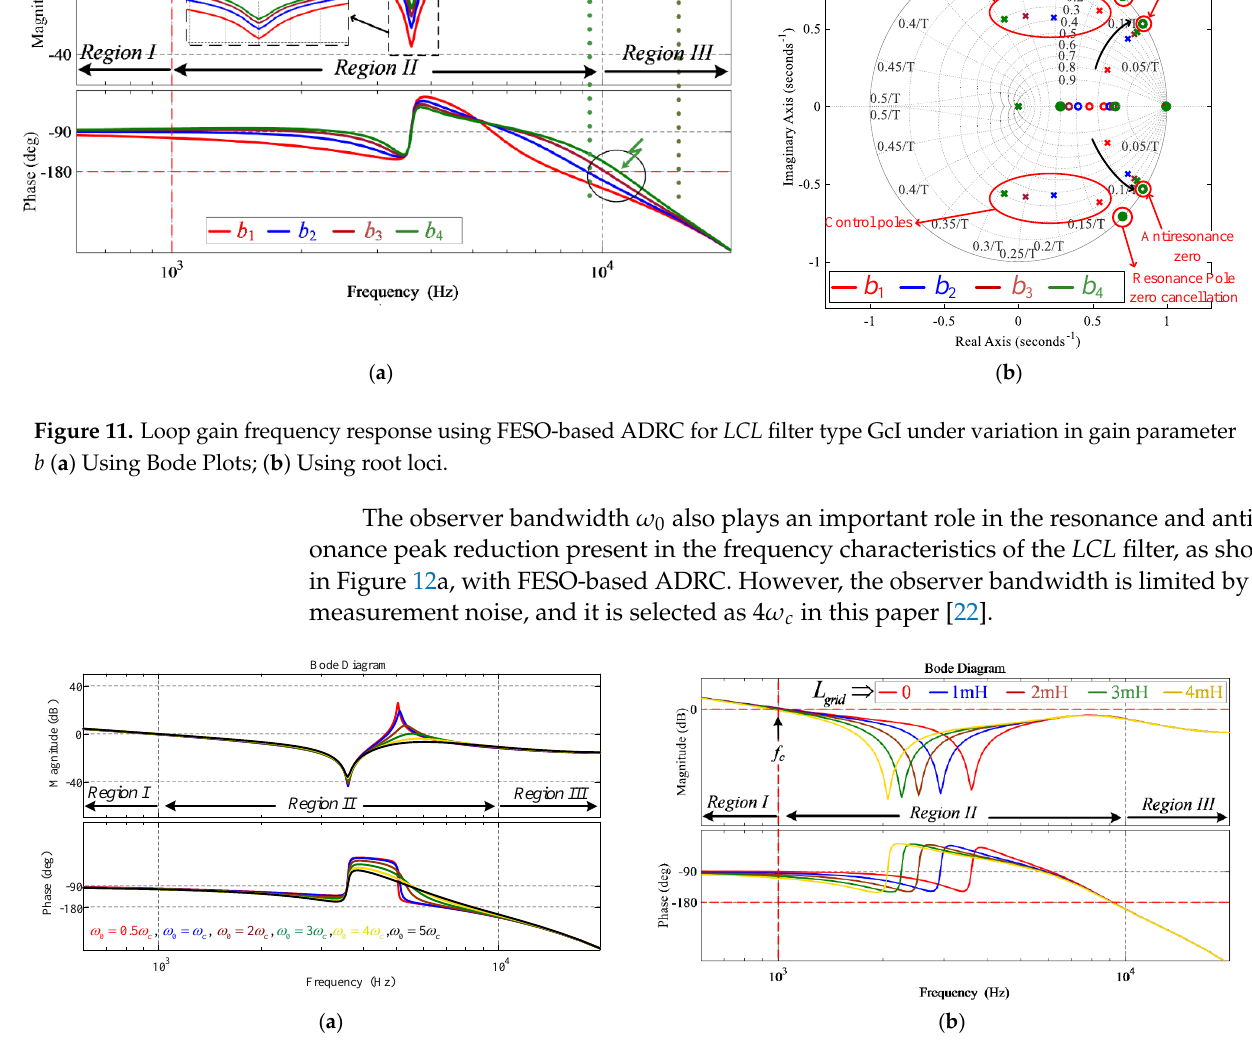
Figure 12. Loop gain Bode plots for LCL filter type GcI with FESO-based ADRC ( a ) Under observer bandwidth variation; ( b ) Under grid impedance variation. Table 5. Stability Analysis of FESO Based ADRC for the LCL Filter Type GcI.